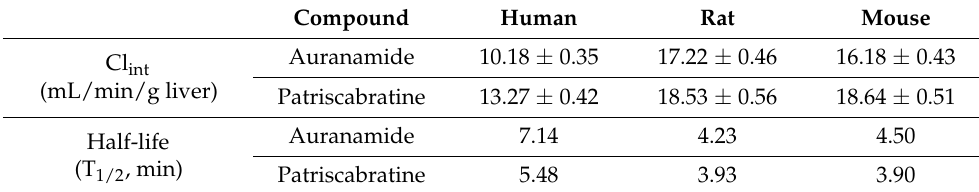
Table 1. Metabolic stability profile of auranamide and patriscabratine in human, rat and mouse liver